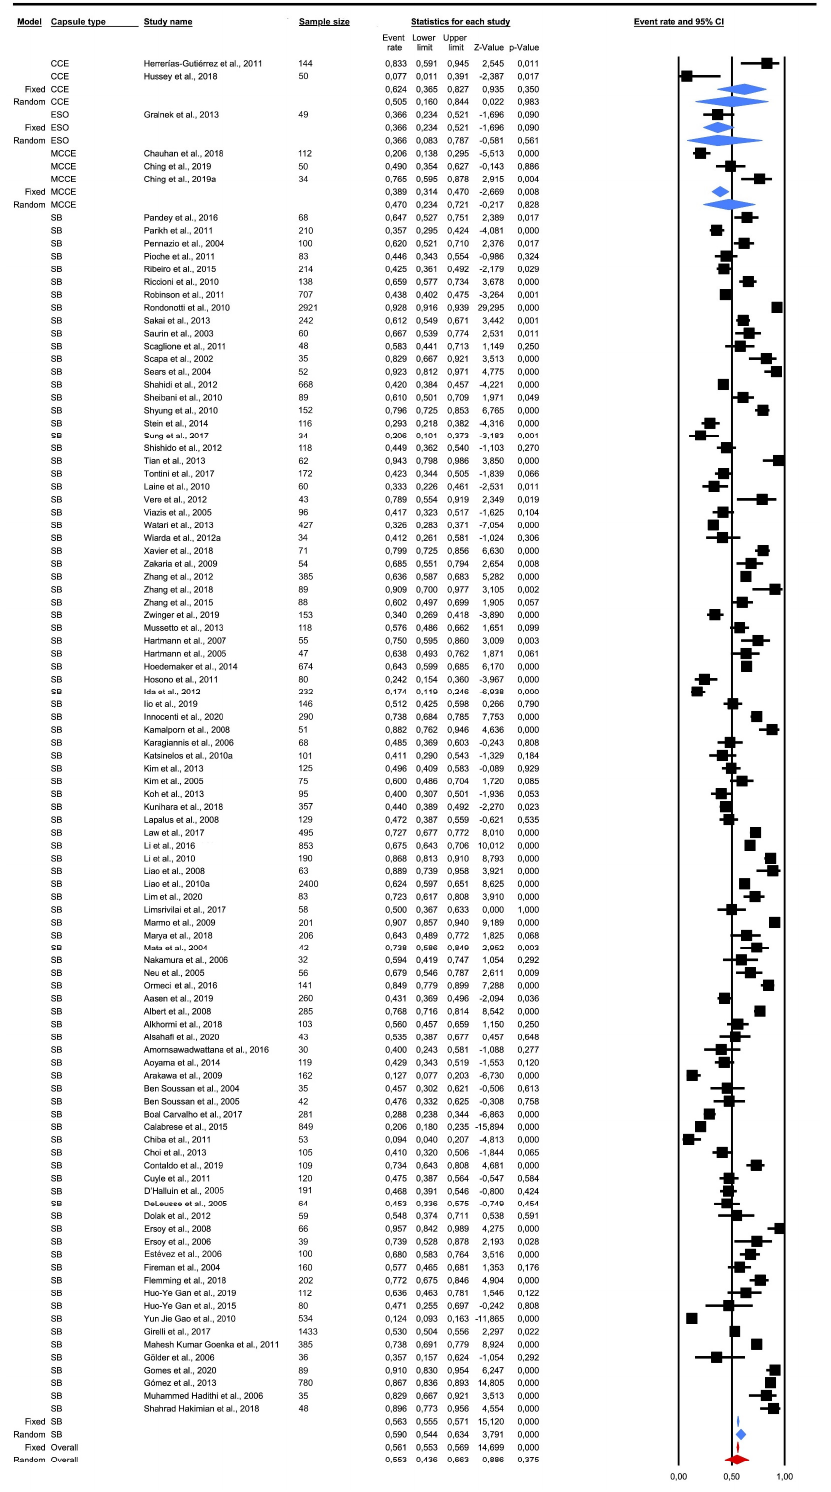
Figure 2. Detection rates in obscure gastrointestinal bleeding by capsule type. Regarding DR, for all lesions, we conducted a meta-regression and found that nei- ther the year of publication (coefficient = − 0.019; standard error (SE) = 0.011, Z = − 1.77, p = 0.076) nor the number of participants per study (coefficient = − 0.0001; SE =